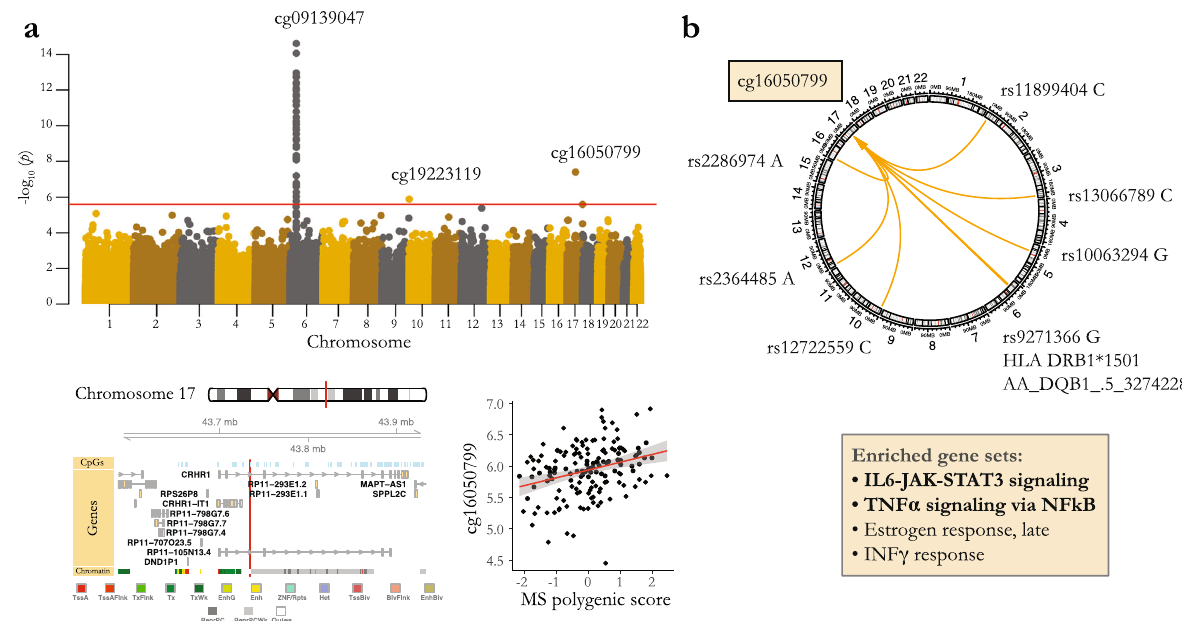
Fig. 5 DNA methylation effects of MS total polygenic score. a Manhattan plot shows association p -values between CpG methylation levels and MS total polygenic score. Red horizontal line shows the signi fi cance threshold (FDR < 5%). Top CpGs in the three signi fi cant regions are speci fi ed. The genomic location for cg16050799 (the top associated CpG outside the MHC region, red vertical line) in relation to nearby CpGs, genes, and modeled chromatin states, in addition to its association with the MS total polygenic score ( Z -scores) is further shown. Error band represents 95% con fi dence interval. Methylation levels are shown in M values. b Genomic locations of MS susceptibility alleles nominally associated with cg16050799 methylation ( p < 0.05) are shown. Gene sets enriched for genes associated with these loci are speci fi